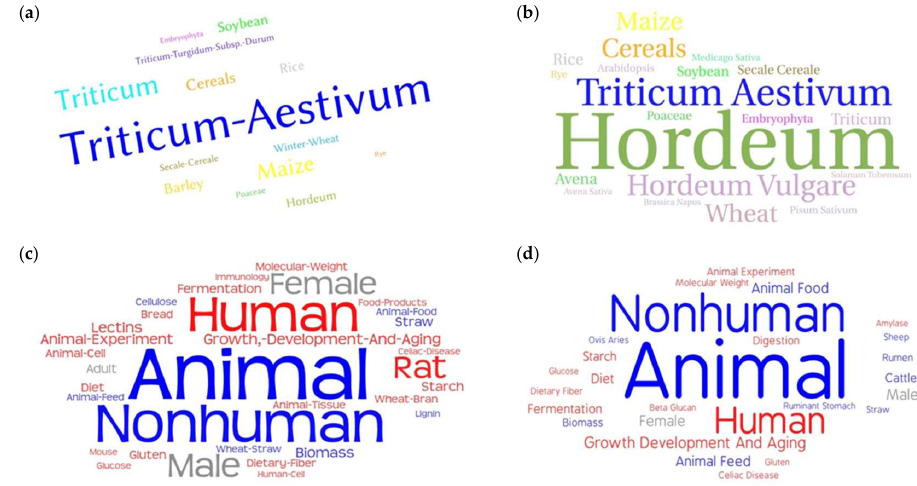
Figure 7. Word cloud based on the main keywords related to cereals and model plants ( a , b ), and human and animals ( c , d ), in wheat ( a , c ) and barley ( b , d ) research documents.